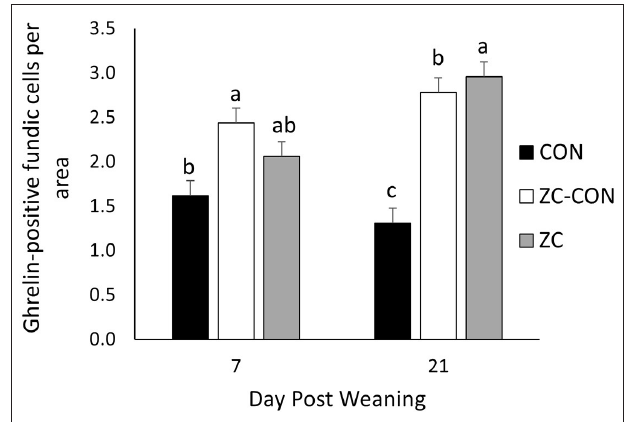
FIGURE 2 | Ghrelin-fundic positive cells between the CON, ZC-CON, and ZC treatment groups at d 7 and 21. At d7, pigs in the ZC-CON group exhibited more ghrelin-positive cells per area (10,138 µ m 2 ) than the CON pigs (2.44 vs. 1.62 cells, respectively, P = 0.005), with ZC pigs being intermediate (2.06 cells). At d 21, pigs in the ZC group exhibited 126% more ghrelin-positive cells per area compared to the CON pigs and 61% more ghrelin-positive cells per area compared to the ZC-CON pigs ( P < 0.001).